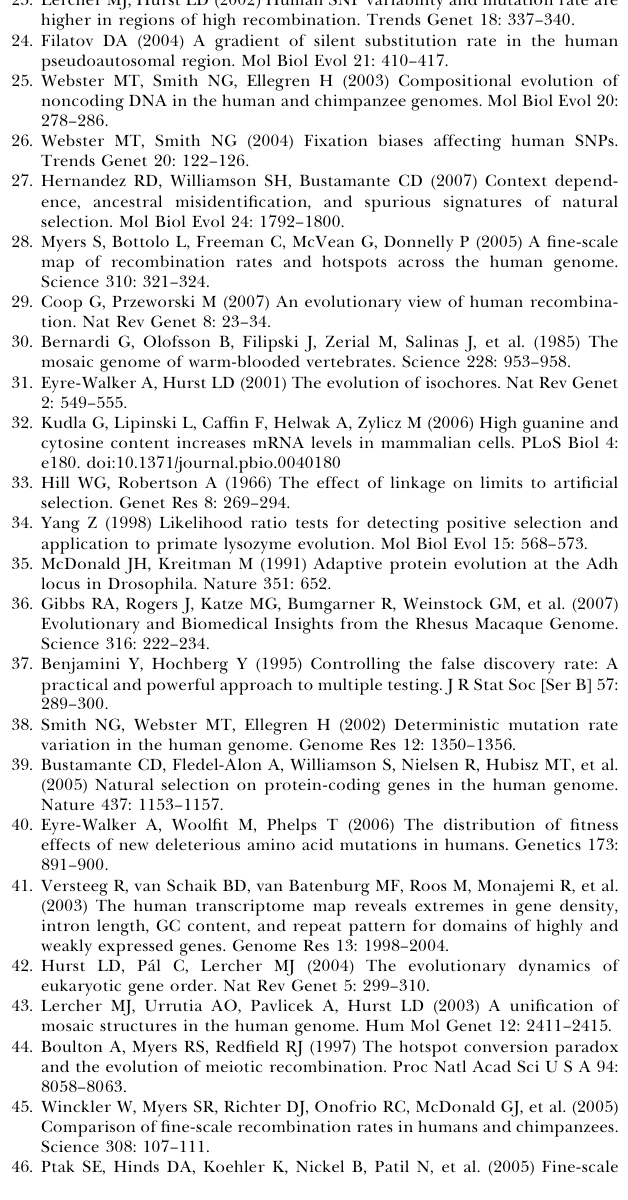
Figure S2. Top 20 Genes with Strongest Evidence for Accelerated d N / d S Based on LRT Exon boundaries are marked with black lines. S ! W substitutions on the human lineage are marked with blue lines, W ! S substitutions on the human lineage are marked with red lines and all other substitutions on the human lineage are marked with grey lines. Found at doi:10.1371/journal.pbio.1000026.sg002 (262 KB EPS). Figure S3. The Predicted Effect of Different Levels of Constraint on the Relationship between W ! S Fixation Bias and d N /d S A selective coefficient ( f ) is used to represent the W ! S fixation bias. The level of constraint is fixed at the following values: (a) 2 3 10 (cid:2) 5 , (b) 4 3 10 (cid:2) 5 , (c) 8 3 10 (cid:2) 5 , (d) 1.6 3 10 (cid:2) 4 . The line colors represent ancestral GC content (0.3–0.4, black; 0.4–0.5, red; 0.5–0.6, green; 0.6–0.7, blue). Found at doi:10.1371/journal.pbio.1000026.sg003 (294 KB EPS). Table S1. LRT Statistics for Human Acceleration and Pattern of Substitution on the Human Lineage for All Exons Found at doi:10.1371/journal.pbio.1000026.st001 (9.13 MB CSV).